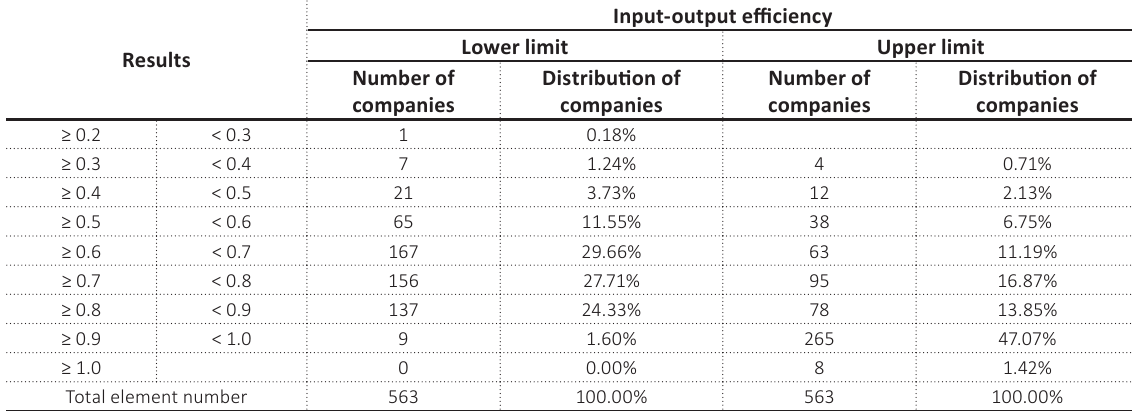
Table 6. Main statistical characteristics of confidence interval values of input-output-oriented efficiency values calculated from the average of the